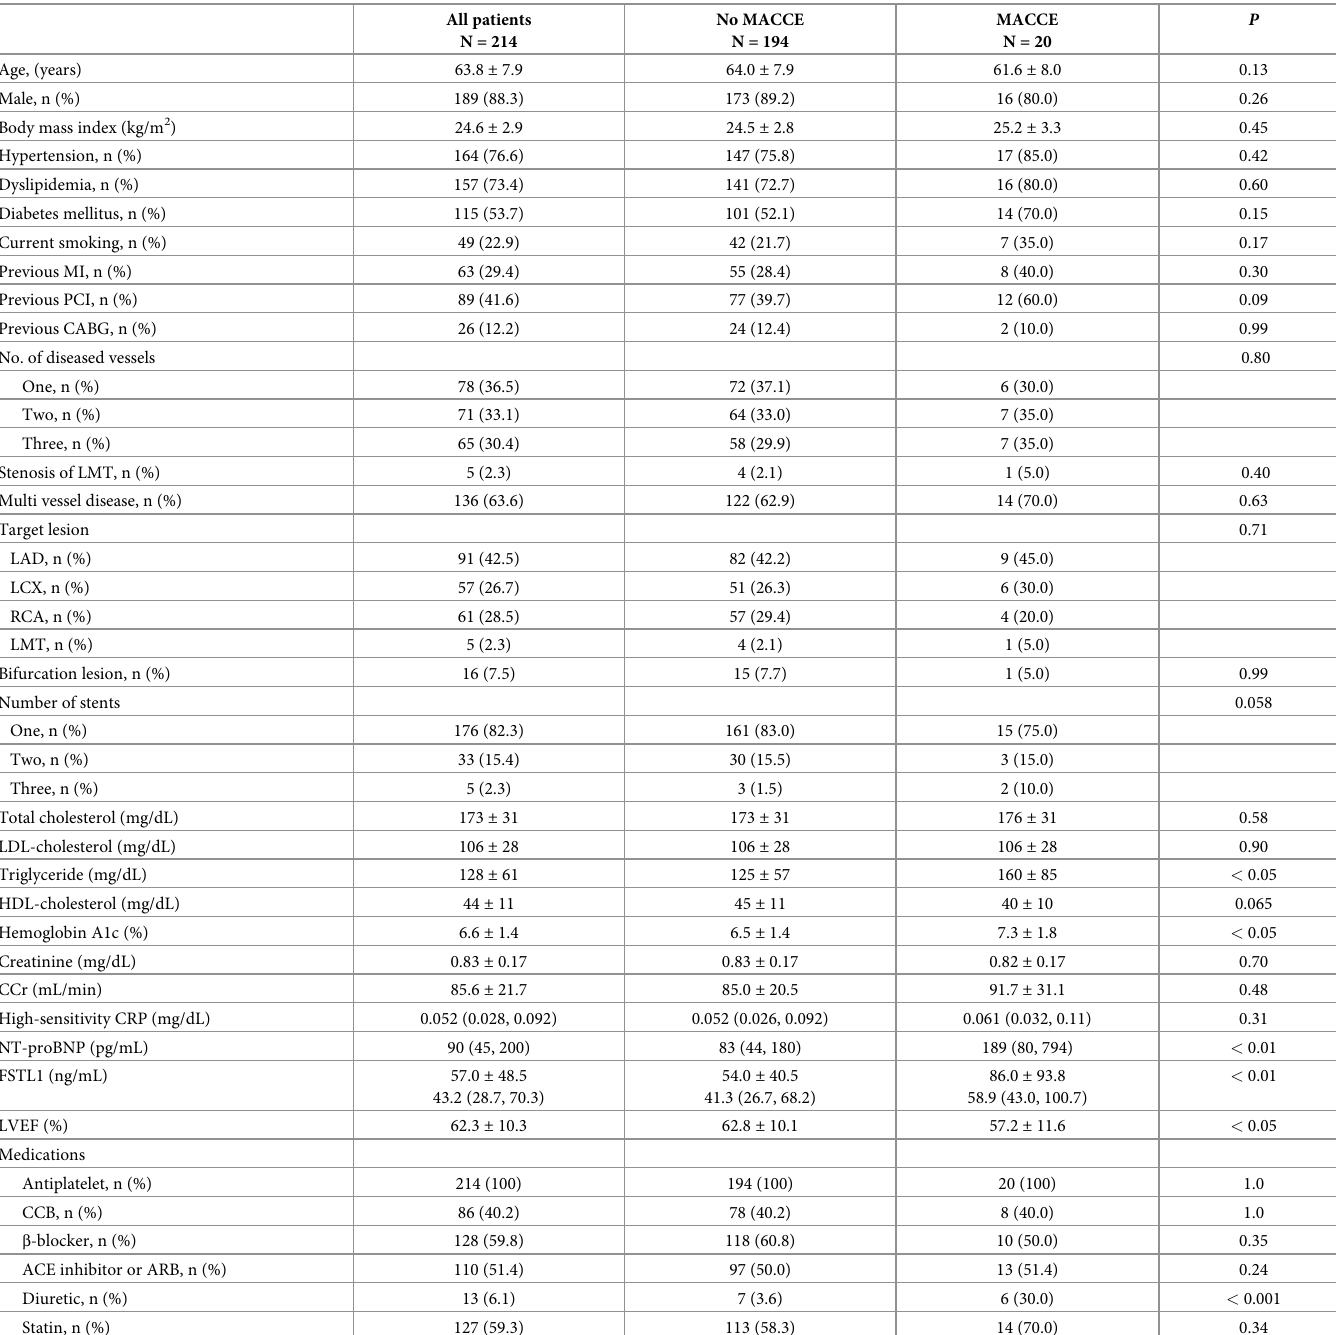
Table 3. Clinical characteristics of patients with preserved renal function, and low